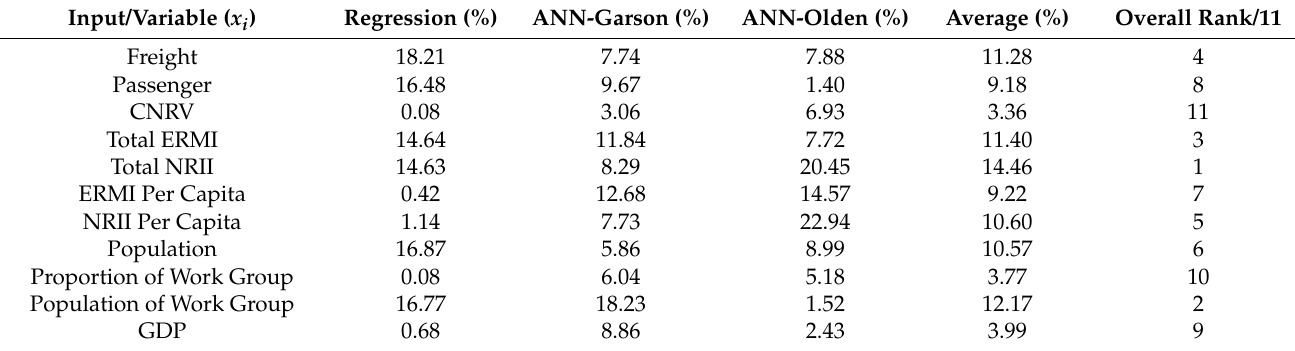
Table 5. Relative influence/importance ranking of